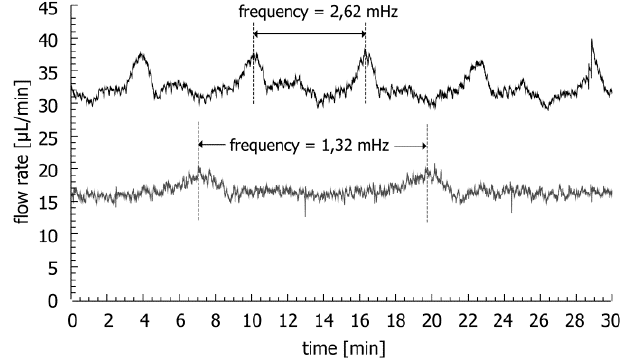
Figure 11. Flow rate measurement for PhD 22/2000 syringe pump (upper curve: flow rate 30 µL/min, lower curve: flow rate 15